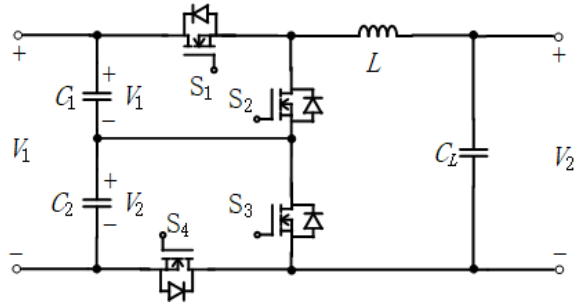
Figure 5. A non-isolated bidirectional DC-DC converter in [14].